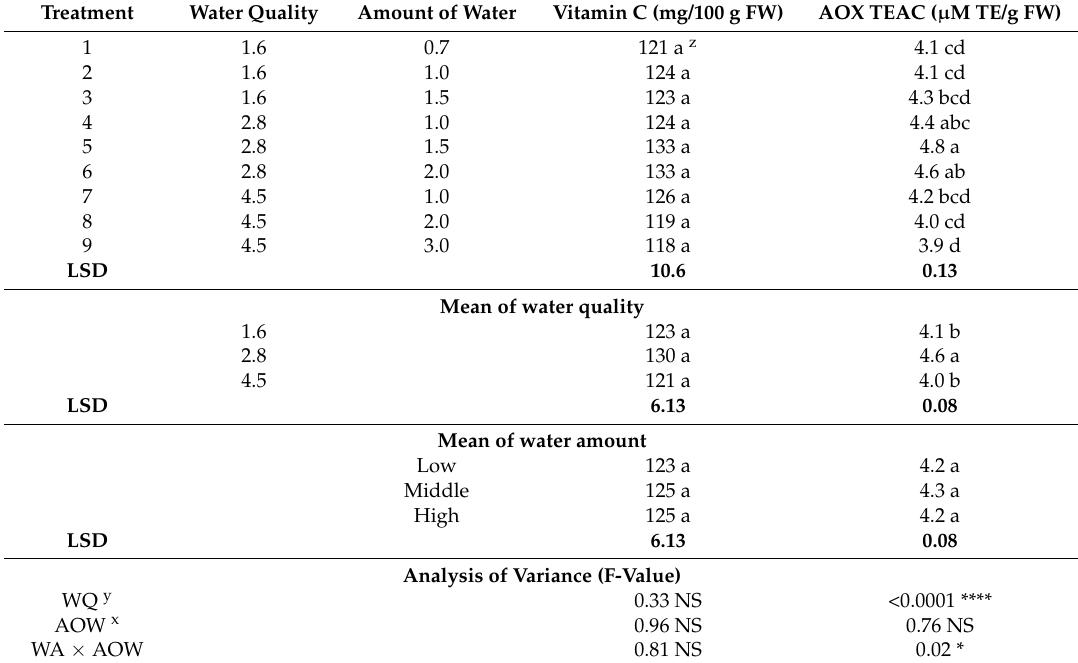
Table 3. Influence of water quality and irrigation water amount on fruit nutritional contents after 14 days at 7 ◦ C plus three days at 20 ◦ C. Means of six harvests over two years. Treatment Water Quality Amount of Water Vitamin C (mg/100 g FW) AOX TEAC ( µ M TE/g FW)